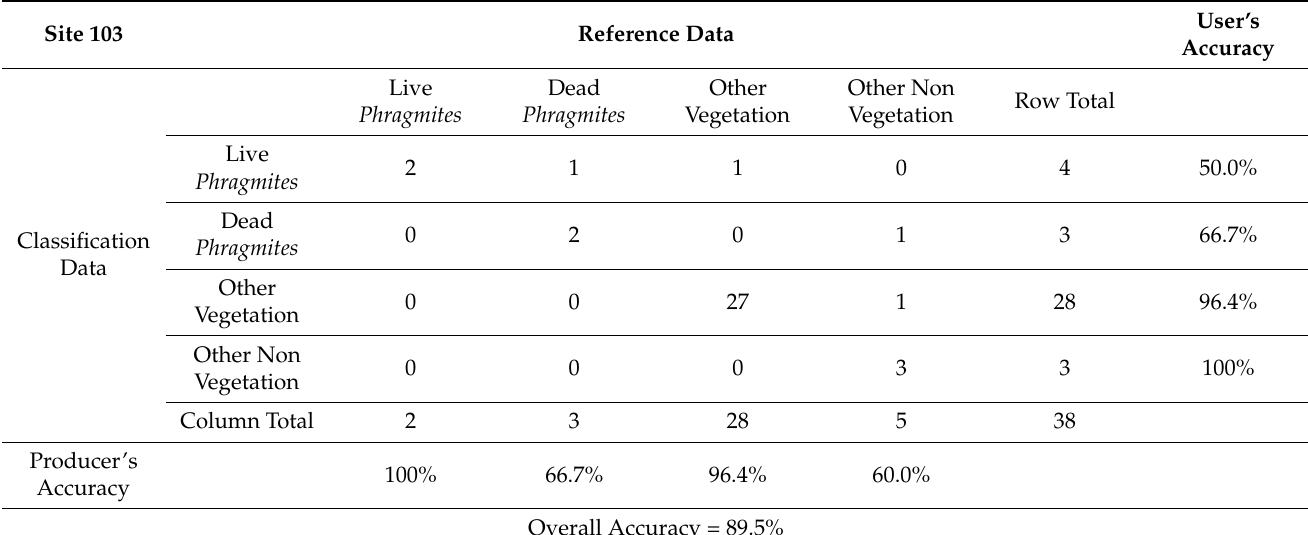
Table 5. Example confusion matrix with validation results for Site 103. In this example, the classification at Site 103 had